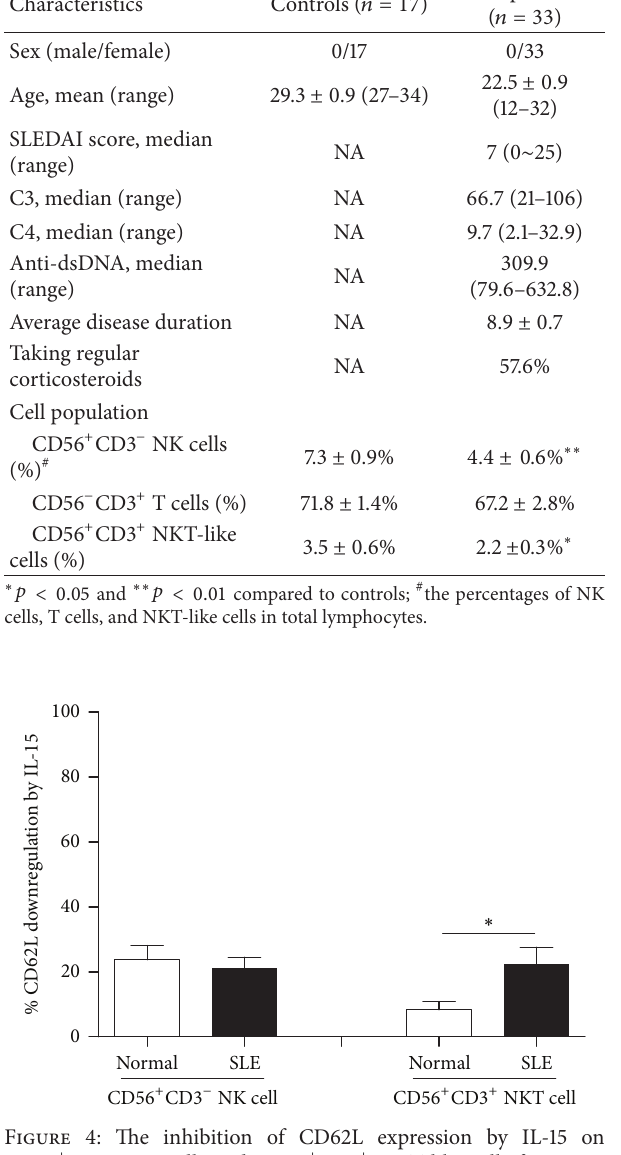
Figure 4: The inhibition of CD62L expression by IL-15 on CD56 + CD3 − NK cells and CD56 + CD3 + NKT-like cells from SLE and healthy donors. PBMCs were stained with anti-CD3, anti- CD56, and anti-CD62L antibodies and were analyzed under flow cytometry. % CD62L downregulation by IL-15 is calculated as [MFI of CD62L in medium − MFI of CD62L in the presence of IL-15 (10ng/mL) for 18 hours/MFI of CD62L in medium] × 100. ∗ 𝑝 < 0.05 (normal, 𝑛 = 10 ; SLE, 𝑛 = 17